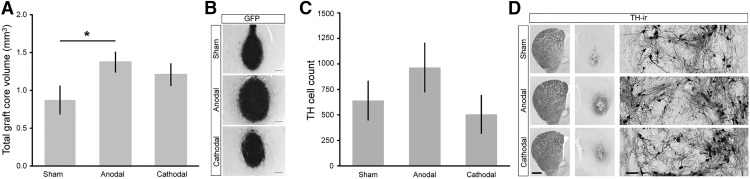
Differential effects of DCS on graft core volume and TH-ir cell count. A, Anodal stimulation resulted in an increased transplant survival reflected in a significantly larger graft core volume compared to sham, which was not significant with cathodal DCS. B, GFP graft cores are illustrated by representative micrographs from each DCS group. Scale bar: 250 µm. C, The number of TH-ir cells in the anodal group was higher compared to the sham DCS group; no increase was present with cathodal DCS. D, TH-ir cells as well as fiber outgrowth are illustrated by representative micrographs from each DCS group. TH-ir cells did not migrate out of the graft core. Scale bars: slice, both hemispheres 1 mm; high-magnification inset, 100 µm. Mean ± SEM; two-tailed Student’s t test each active stimulation versus sham; *p < 0.05.